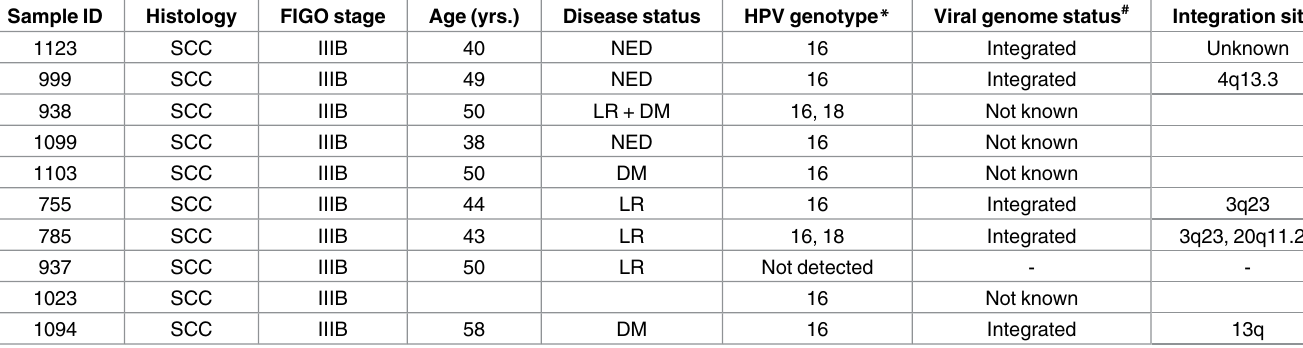
Table 1. Demographic details of the 10 patients included in the whole exome sequencing study Sample ID